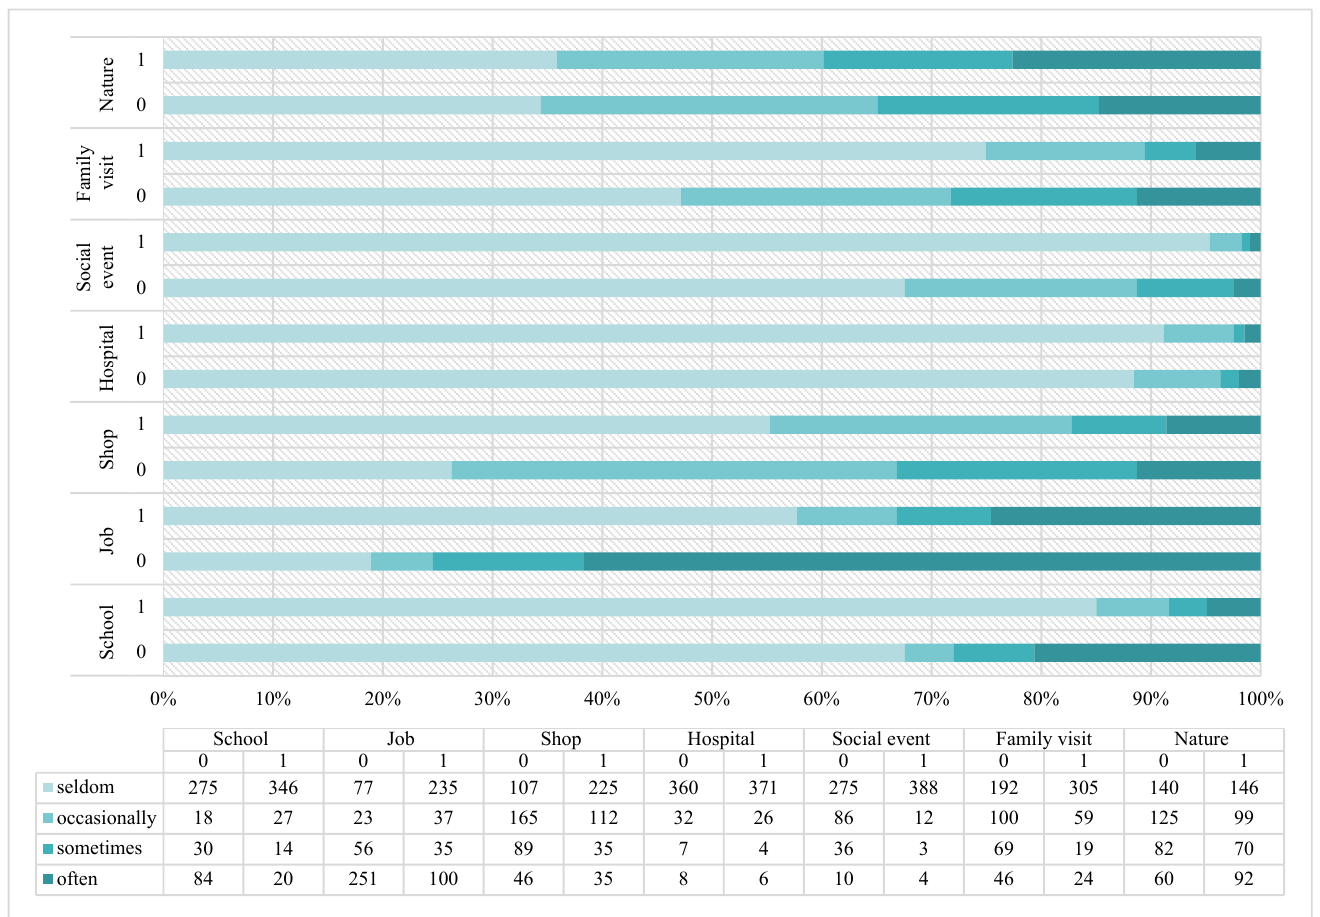
Figure 3. The frequency per week for selected activities before and during the COVID-19 pandemic.